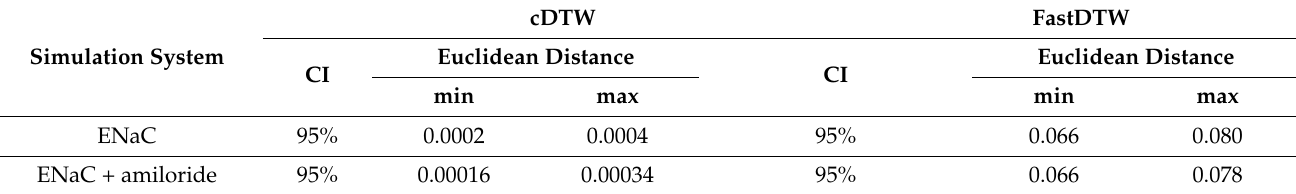
Table 2. The confidence interval (CI) and Euclidean distances derived for theoretical spectra of xENaC from the simulation system without amiloride (ENaC) and with amiloride (ENaC + amiloride) using cDTW and FastDTW